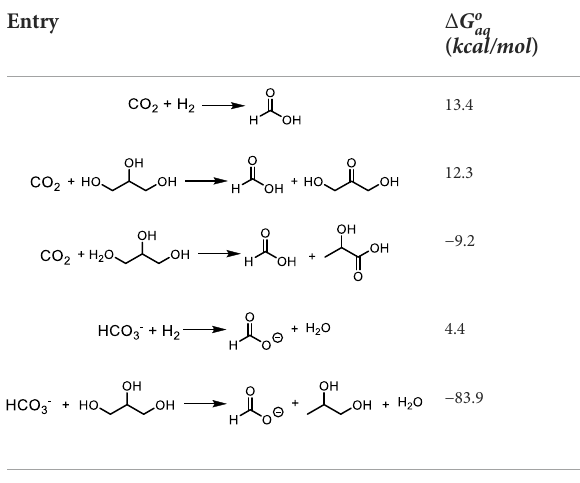
TABLE 1 Calculated free energies of reaction ( Δ G o aq ) for the CO 2 direct hydrogenation and catalytic transfer hydrogenation (Gaussian16, G3B3, PCM water) (Heltzel et al.,